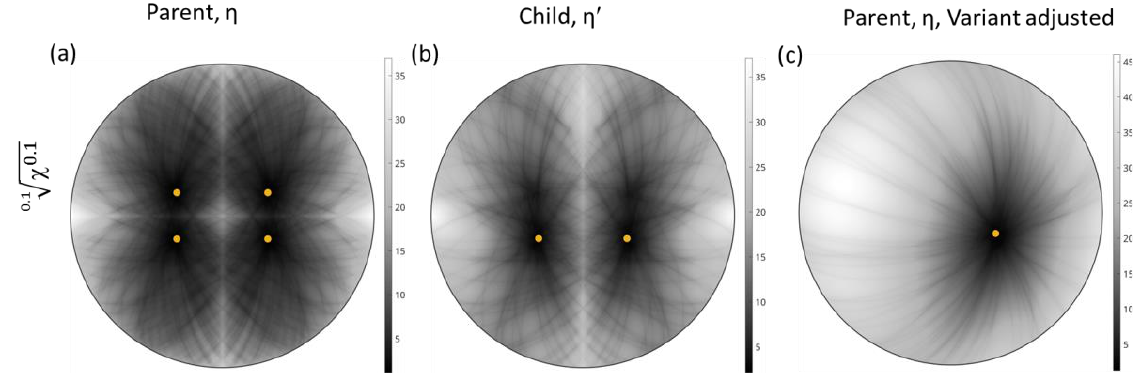
Figure A3. Illustration of the direction-dependent value 0.1 χ 0.1 for uncorrected parent traces ( a ), uncorrected child traces ( b ) and the variant adjusted parent traces ( c ). The orange points indicate the determined habit plane poles at the minimum.